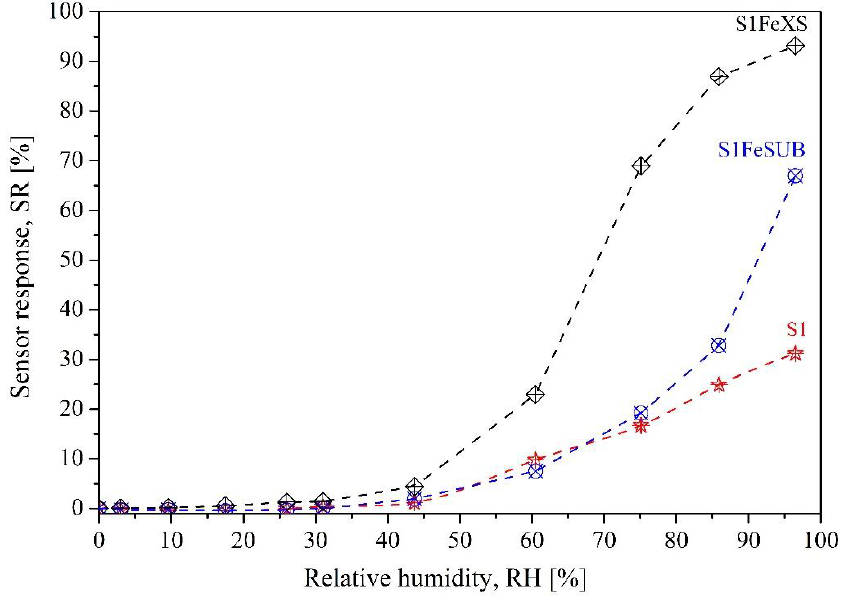
Figure 9. Sensors’ response to humidity at ambient temperature.